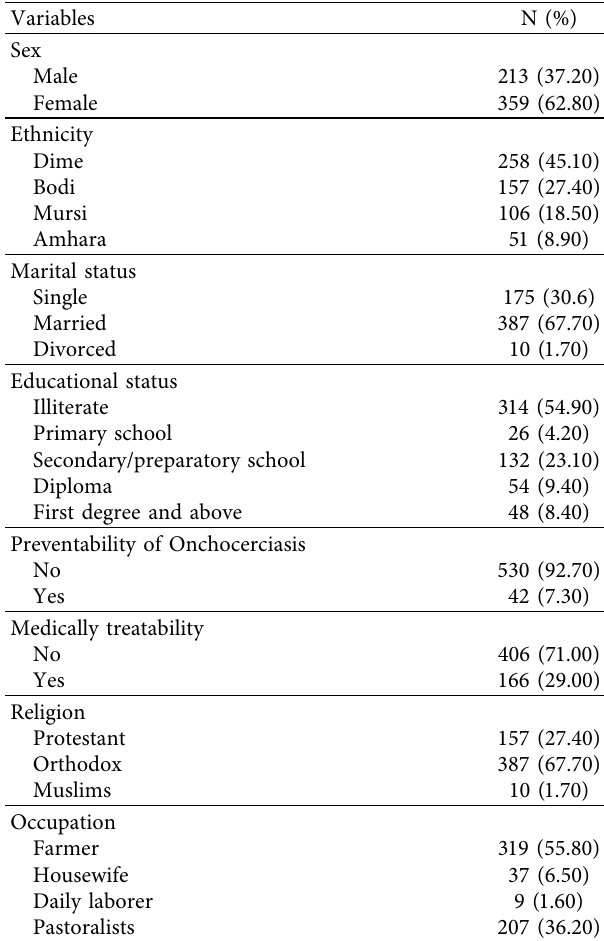
Table 1: The distribution of socio-demographic characteristics of the study participants at Selamago woreda in